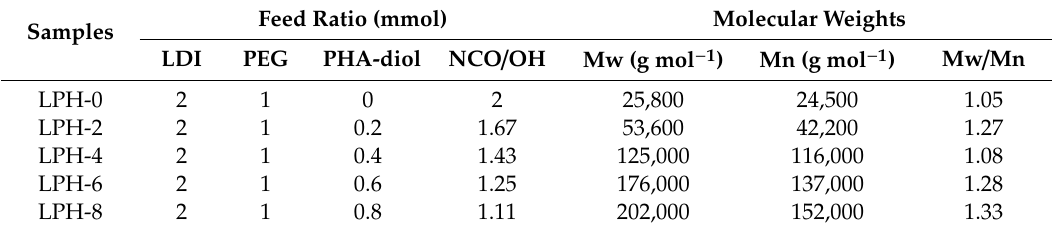
Figure 1. ( A ) Synthesis scheme of PHA-diol and ( B ) synthesis scheme of LPH. Table 1. The formulation of synthesized LPH Table 1. The formulation of synthesized LPH films.